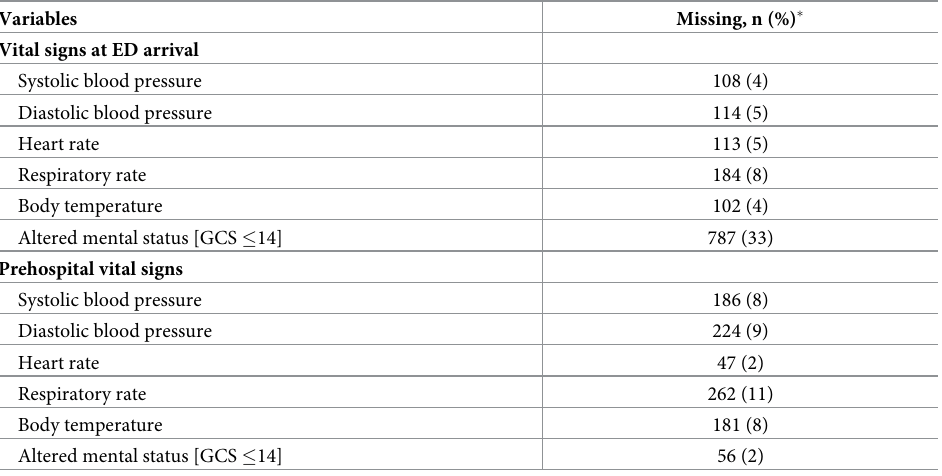
Table 1. The proportion of missing variables in 2,407